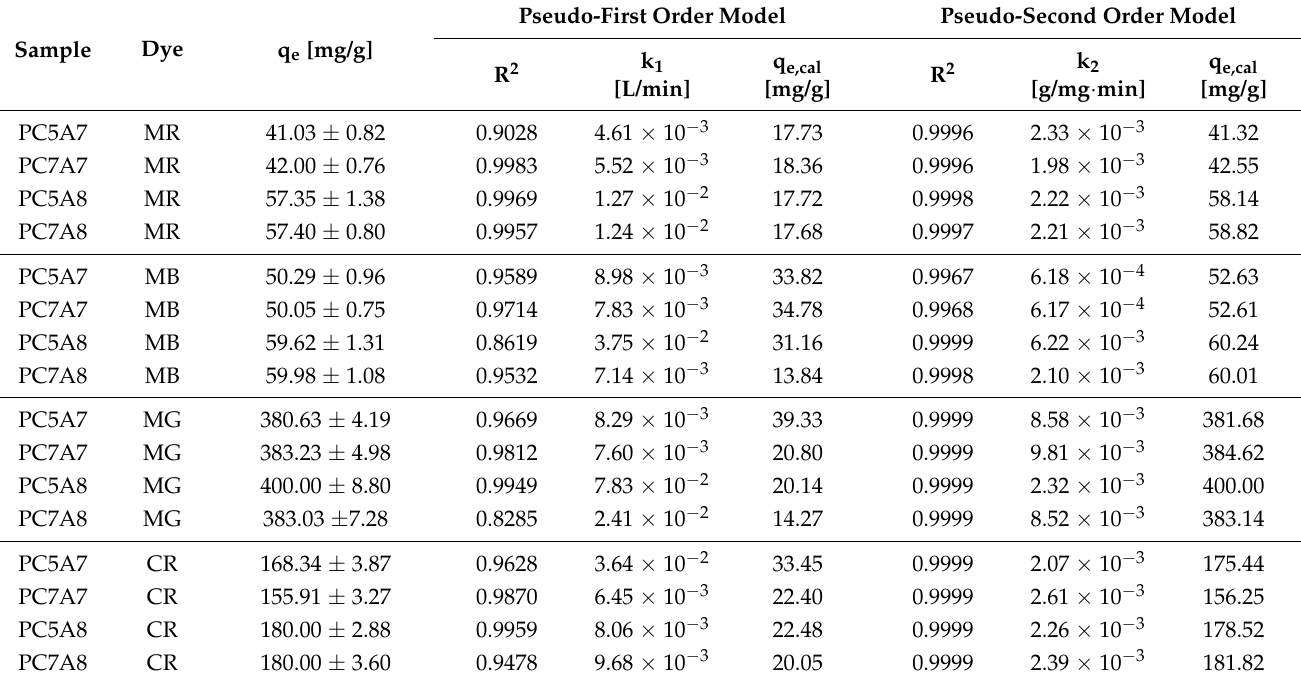
Table 6. Adsorption kinetics parameters for the adsorption of organic dyes onto activated carbons.